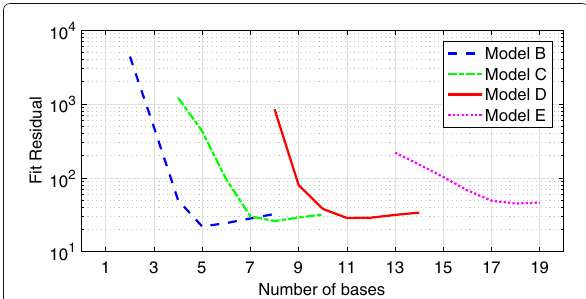
Fig. 1 Results of the base selection process. The output of the solver is shown for different numbers of base sinusoids of Wi-Fi channel model B to E, when the number of subcarriers is 64